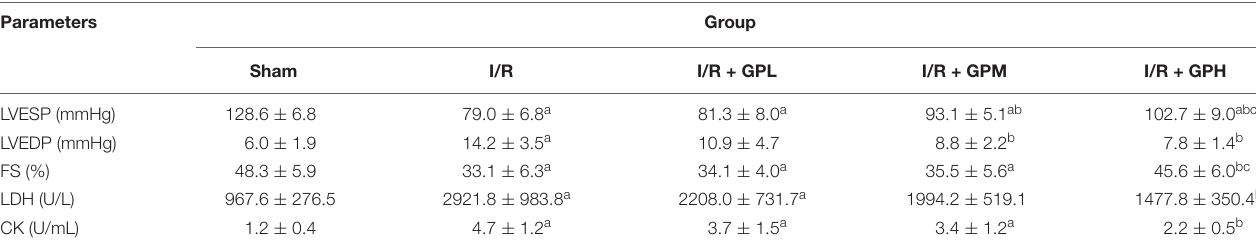
TABLE 1 | Treatment with gypenoside (GP) improved the cardiac function in model animals (mean ± SD).